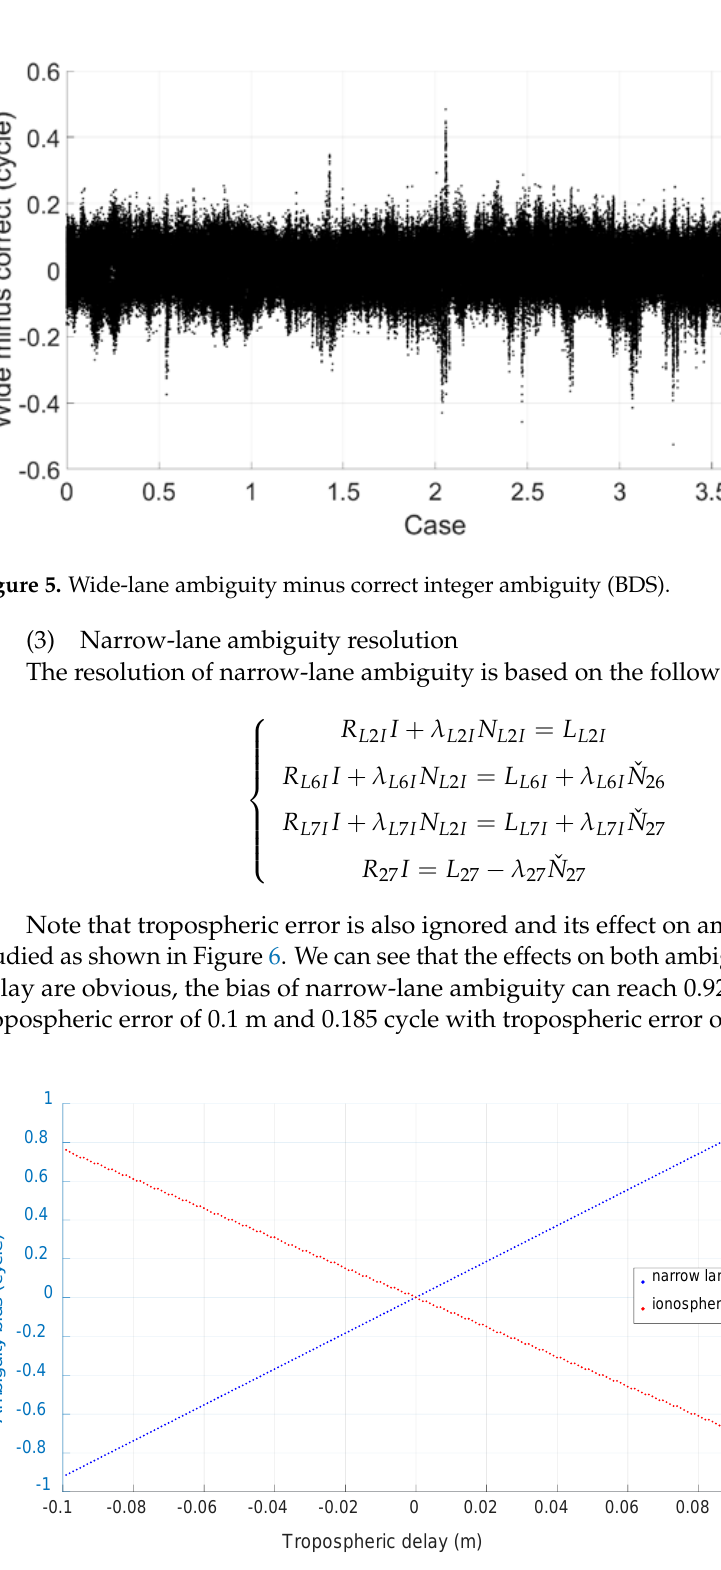
Figure 6. The caused bias of neglected tropospheric error (BDS). In order to reduce the effect of tropospheric error on narrow-lane ambiguity resolu- tion, a new differencing scheme between satellites is proposed in which differencing is formed between satellites with closest tropospheric mapping functions. Figure 7 shows the statistics of the mapping function range after differencing between BDS satellites